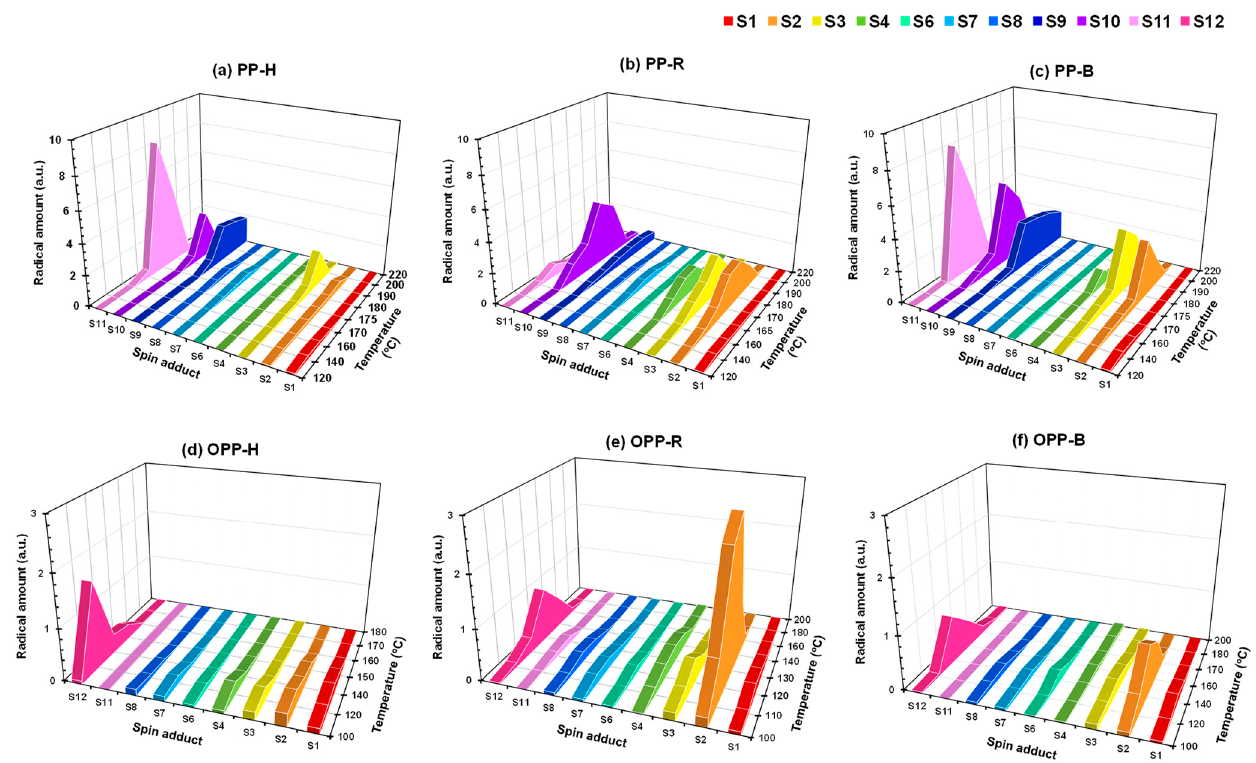
Figure 7. Radical amounts of spin adducts produced during stepwise heating of PP granules, ar- ranged by temperatures for each spin adduct: ( a ) PP-H, ( b ) PP-R, ( c ) PP-B, ( d ) OPP-H, ( e ) OPP-R, and ( f ) OPP-B.